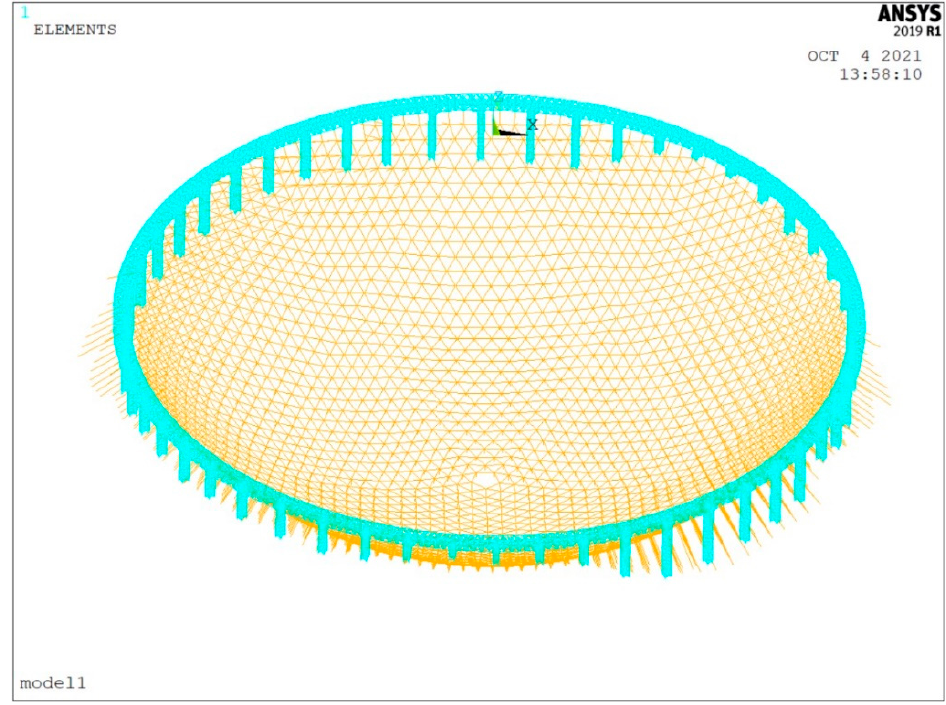
Figure 3. ANSYS model of FAST cable net.